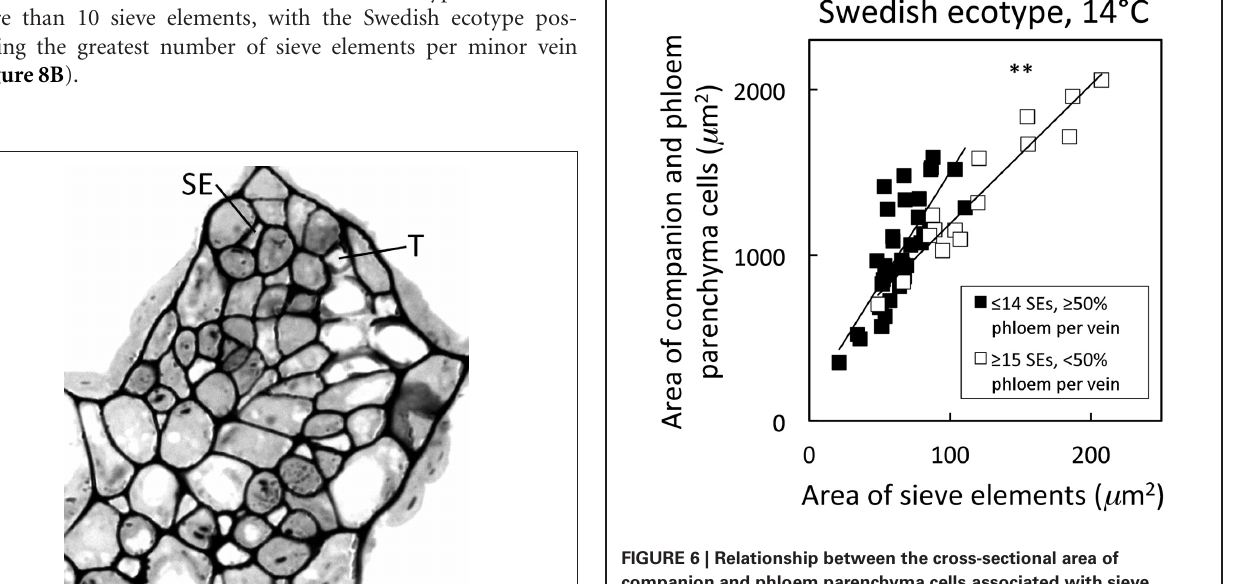
FIGURE 6 | Relationship between the cross-sectional area of companion and phloem parenchyma cells associated with sieve elements and the area of sieve elements for individual second-, third-, and fourth-order veins from the A. thaliana Swedish ecotype grown at 14 ◦ C under 400 µ mol photons m − 2 s − 1 . Individual veins ( n = 52) were segregated by sieve element (SE) number and ratio of phloem area/vein area into veins containing ≤ 14 SEs and phloem area/vein area ≥ 0.5 (black squares; putative minor loading veins) or ≥ 15 SEs and phloem area/vein area < 0.5 (open squares; second order veins). Linear regression lines drawn for each segregated group of veins ( ≤ 14 SEs or ≥ 15 SEs), and statistically significant differences in slope and intercept (ANCOVA) between regression lines is indicated ( ∗∗ = P < 0 . 01). Linear regression analyses for each line are y = 13 . 6 x + 142, R 2 = 0 . 60, and P < 0 . 001 (black squares) and y = 8 . 4 x + 351, R 2 = 0 . 91, and P < 0 . 001 (open squares).